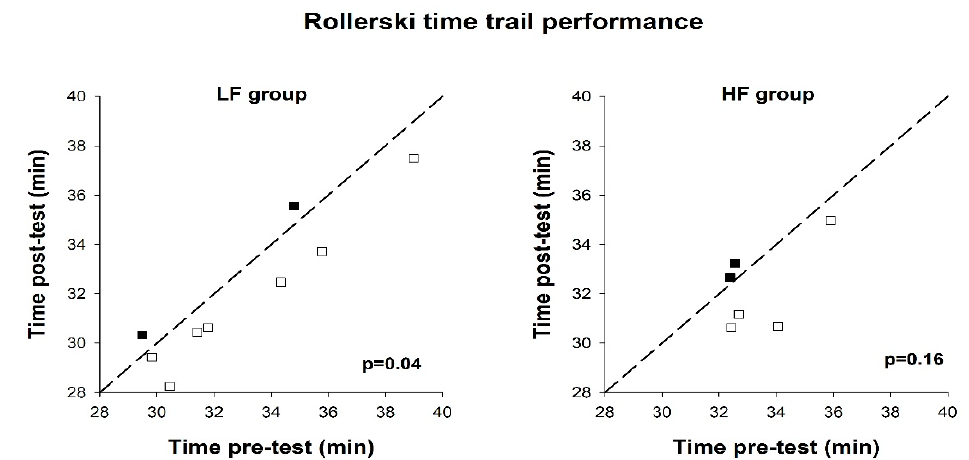
Figure 2. Time taken to complete the 8 km rollerski time-trial, pre-test and post-test, in the low-frequency group (LF group) and high-frequency group (HF group). Reference lines indicate identical values pre- and post-test. Each box represents a test subject. Open boxes indicate an improvement, and filled boxes indicate a decline, compared to the pre-test.